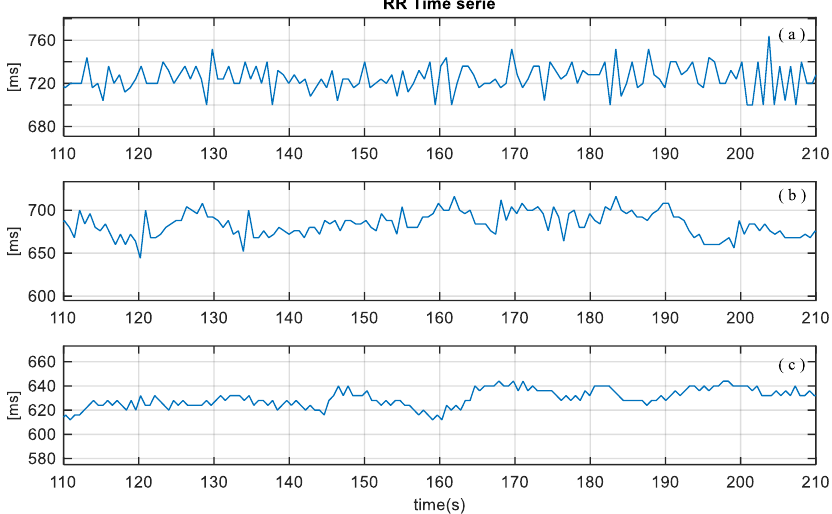
Figure 3. Excerpt of beat-to-beat interval ( RR ) from a patient of ( a ) successful group (SG), ( b ) failed group (FG), and ( c ) reintubated group (RG).